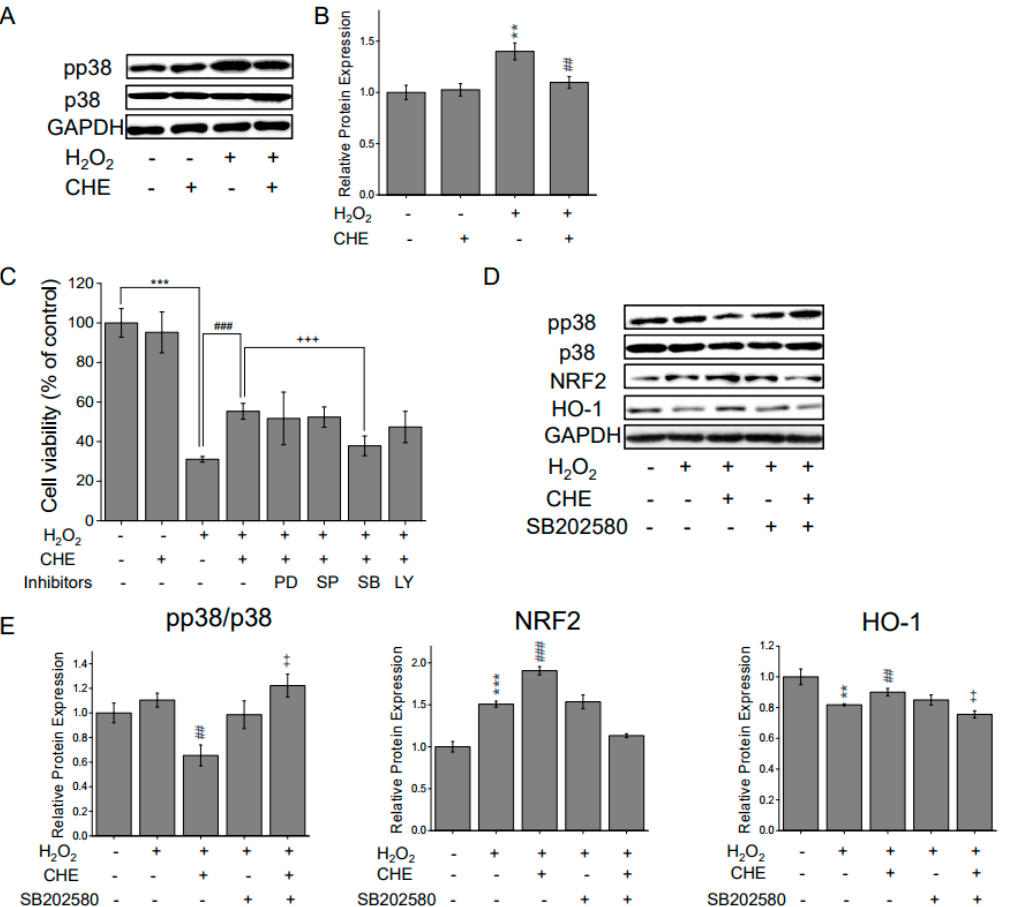
Figure 6. CHE inhibits the activation of p38 MAPK during H 2 O 2 -induced oxidative stress, and p38 MAPK inhibition mediates CHE-induced Nrf2 activation. ( A ) ARPE-19 cells were treated with or without 5 µ M CHE for 2 h and then treated with H 2 O 2 for 30 min. ( C ) Cells were pre-treated with a specific kinase inhibitor (PD98059 (ERK), SP600125 (JNK), SB203580 (p38), or LY 294002 (PI3K)) at 10 μ M for 2 h, 5 μ M CHE for another 2 h, and then followed by treatment with 500 μ M H 2 O 2 for 24 h. Cell viability was quantified via the CCK-8 assay. ( D ) ARPE-19 cells were pre-treated with a p38 inhibitor at 10 μ M for 2 h, 5 μ M CHE for another 2 h, and then treated with 500 μ M H 2 O 2 for 24 h. The protein levels of p38, pp38, HO-1, NQO-1, and Nrf2 were assessed via Western blotting. ( B , E ) The quantitative analysis of the p38, pp38, HO-1, NQO-1, and Nrf2 levels was performed via densitometric measurements relative to the control. ** p < 0.01, *** p < 0.001, versus control group; ## p < 0.01, ### p < 0.001, versus the H 2 O 2 -treated group; ++ p < 0.01, +++ p < 0.001, versus the H 2 O 2 and chrysoeriol-treated group.